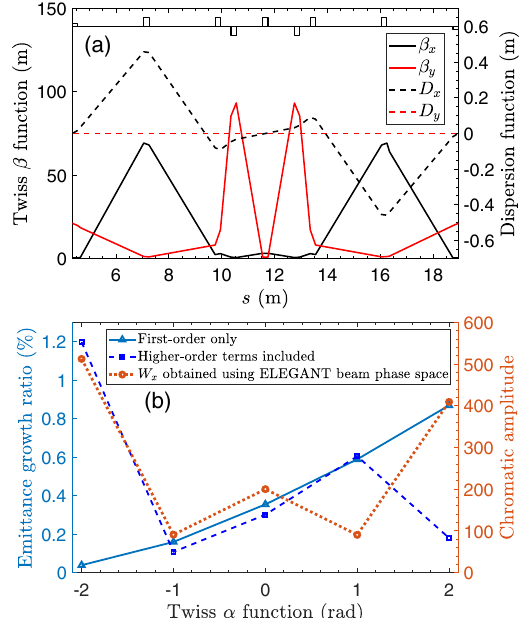
FIG. 10. (a) Twiss parameters and dispersion functions along the achromatic dog-leg transfer line with 7 quadrupole magnets for initial Twiss β ¼ 0 . 1 m and Twiss α ¼ 0 . (b) Chromatic amplitude and emittance growth ratio.